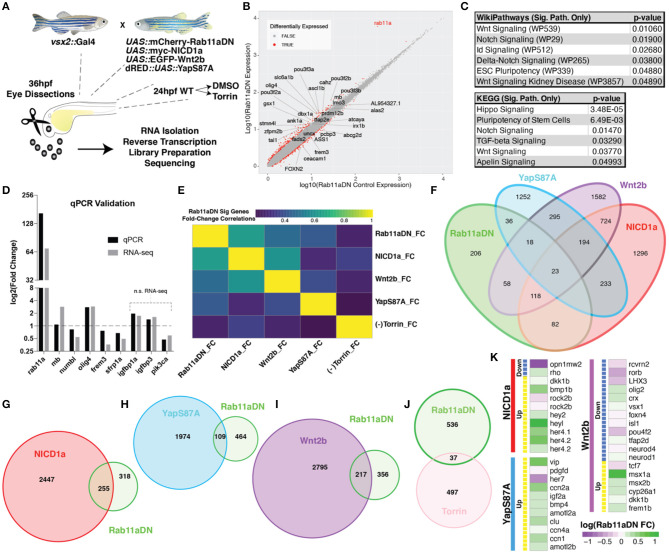
RNA-sequencing of Rab11aDN retinas identifies shared features with modulation of multiple signaling pathways control RPC proliferation. (A) Schematic of genetics for input for RNA-sequencing experiments to test changes in retinal transcript expression resulting from Rab11aDN expression, Notch-pathway activation (NICD1a), Wnt-pathway activation (Wnt2b), inactive Hippo pathway (YapS87A; Yap constitutive active), or inhibition of mTOR signaling (Torin). (B) Global analysis of differentially expressed transcripts in 36 hpf Rab11aDN retinas. Differentially expressed transcripts are indicated in Red. Gene names are listed for differentially expressed transcripts that display high residual to the mean. (C) Target pathways from IPA pathway analysis on Rab11aDN differentially expressed transcripts using WikiPathways (top) and KEGG pathways (bottom). (D) qRT-PCR validation of RNA-sequencing results for transcripts associated with the Notch (mb and numb), Hippo (olig4 and frem3), Wnt (sfrp1a), and mTOR (igfbp1a, igfbp3, pik3ca) pathway modulations. (E) Correlation of the fold changes of differentially expressed transcripts from Rab11aDN experiments with the fold changes observed in additional RNA-seq samples, indicating similarity between transcript signatures. (F–J) Venn diagrams of differentially expressed transcripts across RNA-sequencing samples of (F) All RNA-sequencing samples performed or pairwise comparisons of Rab11aDN differentially expressed transcripts with (G) NICD1a, (H) YapS87A, (I) Wnt2b overexpression studies, or (J) inhibition of mTOR signaling using the Torin inhibitor. (K) Heatmaps of Up- (Yellow) or Down-regulated transcripts within NICD1a, YapS87A, or Wnt2b experiments indicating the corresponding expression fold change in Rab11aDN studies.